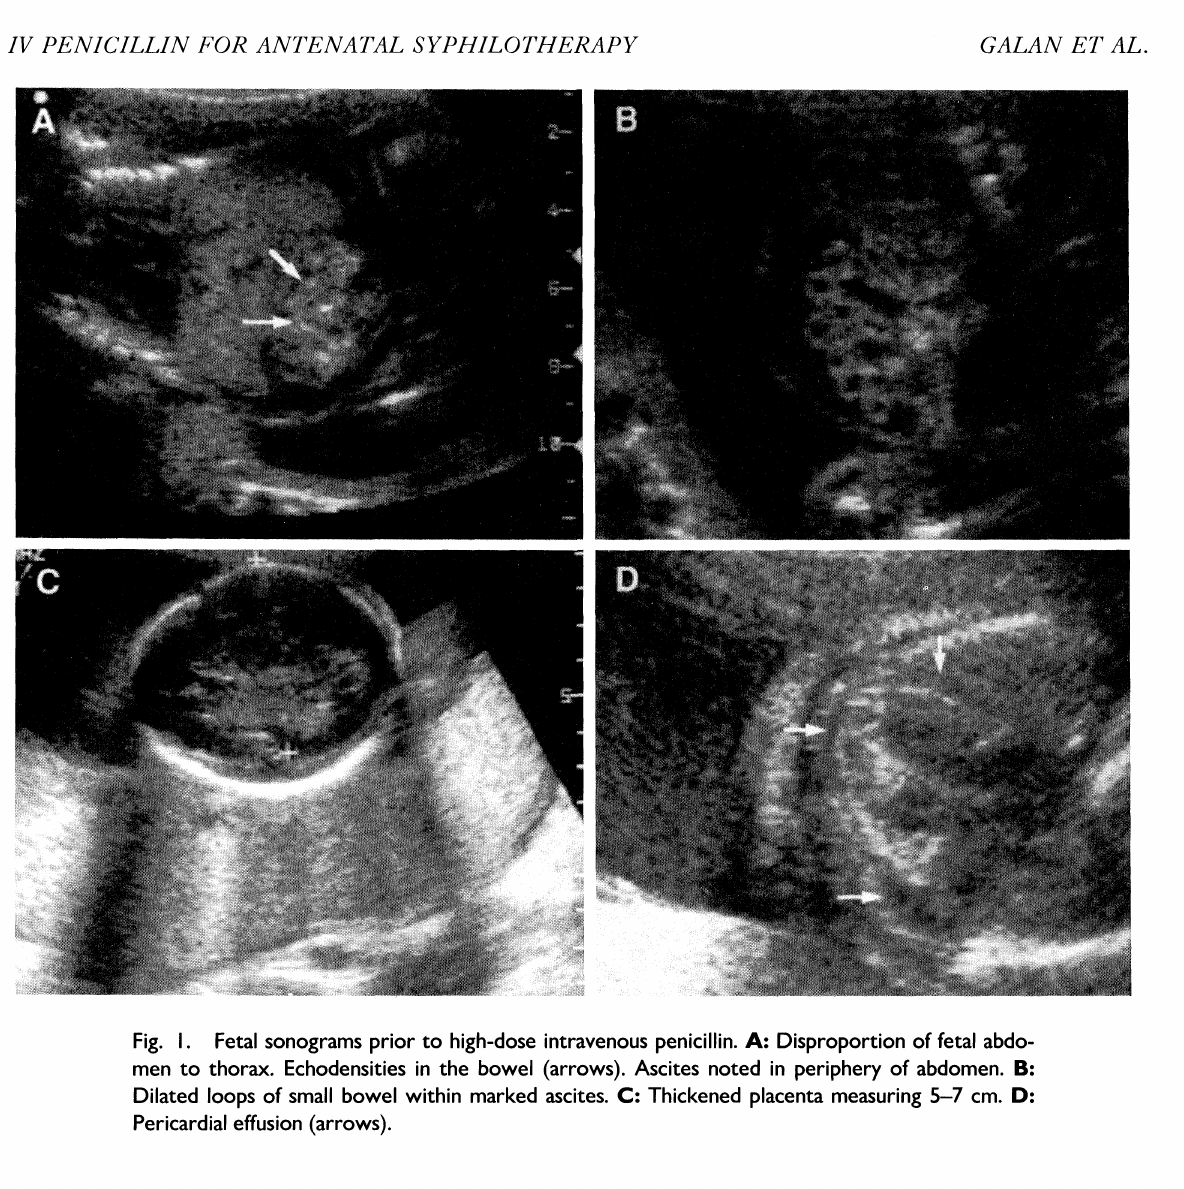
.: Disproportion of fetal abdo-